Question: Name the type of graph shown.
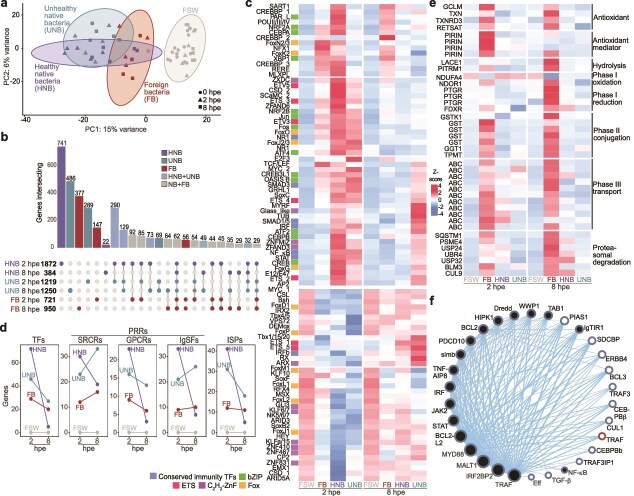
Answer: heatmap